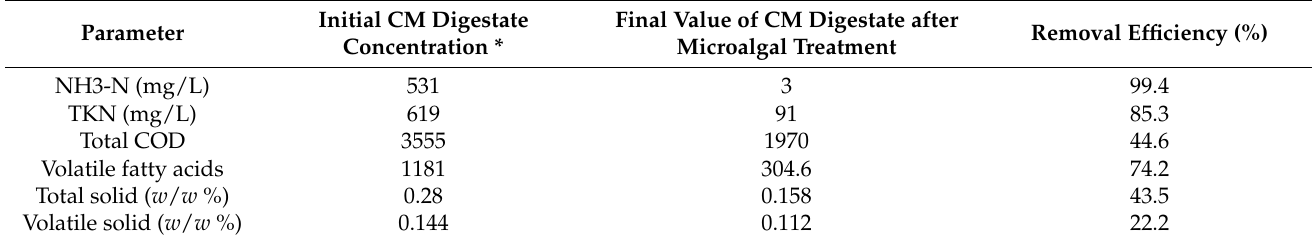
Table 3. Digestate characteristics from the algal incubation